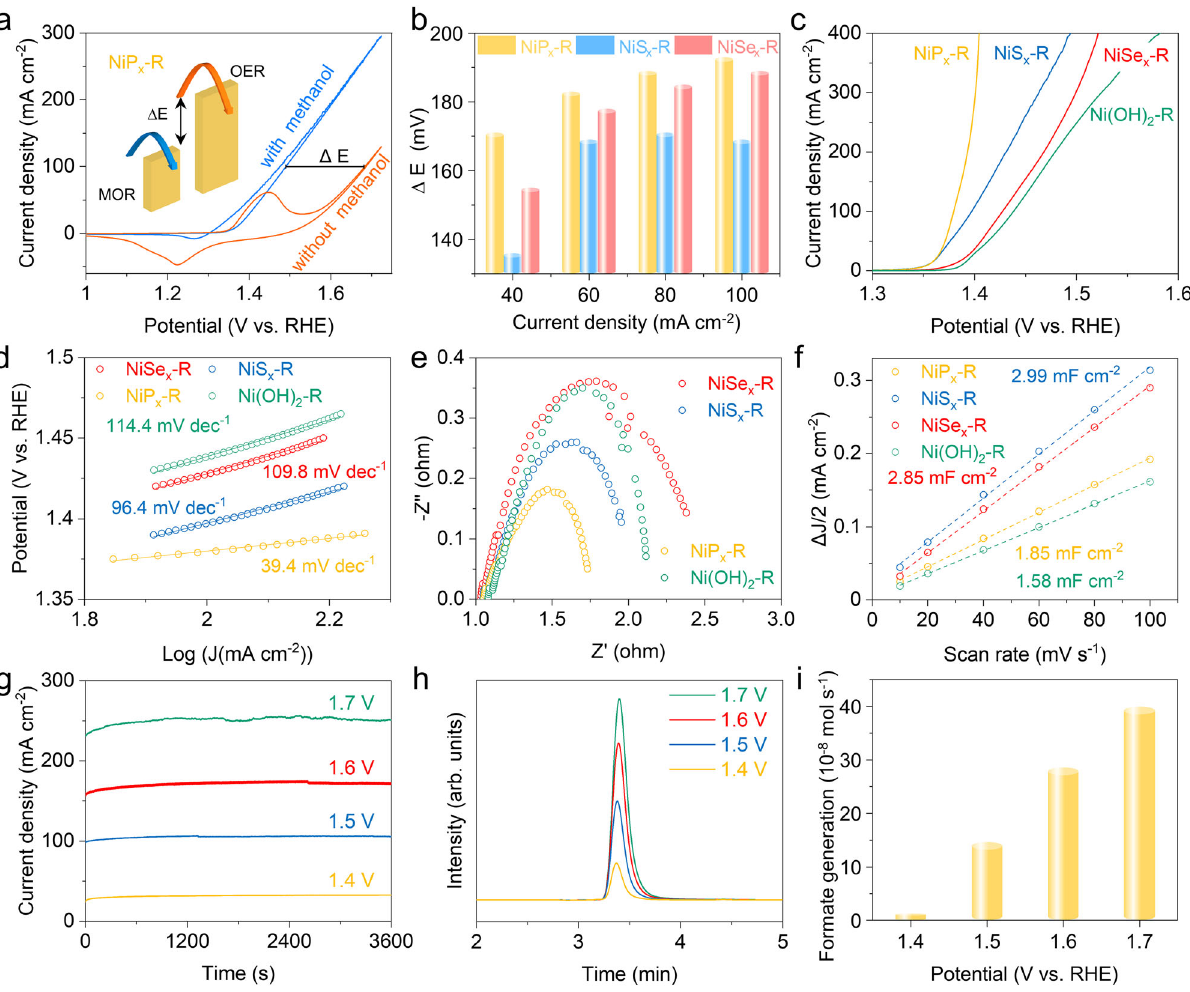
Fig. 4 Electrocatalytic MOR performance. a CV curves of NiP x -R in 1 M KOH solution with and without 0.5 M methanol at a scan rate of 5 mV s − 1 . b The potential difference between MOR and OER at different current densities. c MOR polarization curves of NiT x -R and Ni(OH) 2 -R as the control sample. d Tafel plots, e electrochemical impedance spectra, and f the extracted double-layer capacitances (C dl ) of different NiT x -R electrodes using a CV method. g Chronoamperometry (I – t) curves and h the IC traces of the diluted electrolyte for methanol upgrading reaction with the NiP x -R anode at 1.4 – 1.7 V (vs. RHE) for 1 h. i The averaged generation rates of formate at different